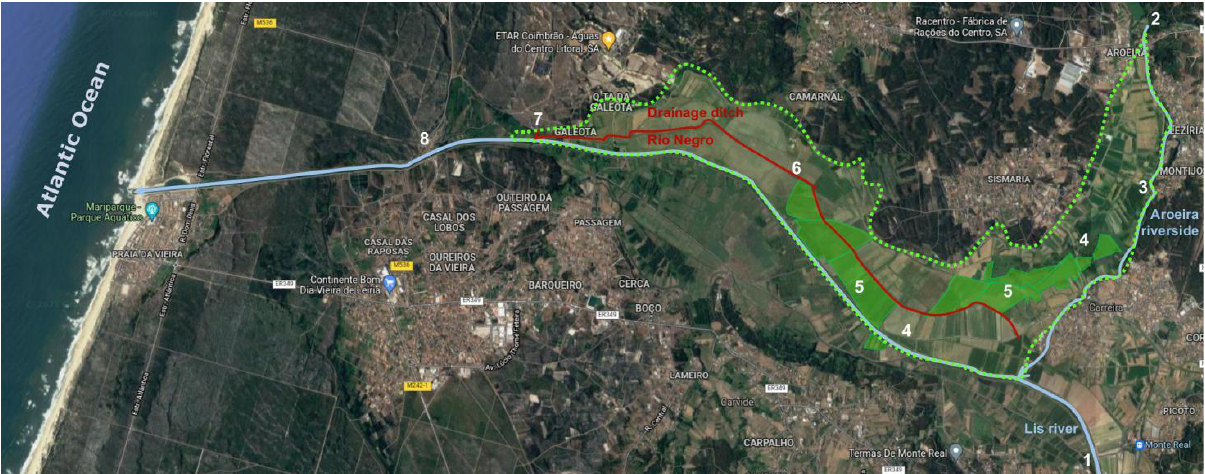
Figure 1. Location of the sampling sites (white figures, 1 – 8), the rice plots (green) in Block II (green dashed line) of Lis Valley Irrigation District (Source: Google Maps, https://www.google.pt/maps/,